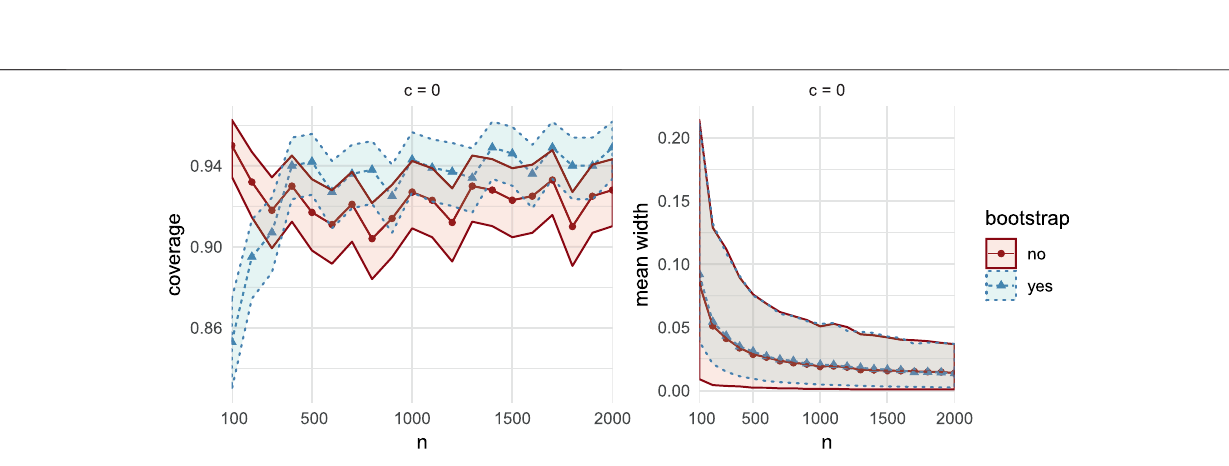
FIGURE 5 | Comparisons of coverage (left column) and mean width (right column) between bootstrap CIs (dashed lines with triangular markers) and the asymptotic CIs (solid lines with circular markers) in MC Study C, for correlation c (cid:2) 0. The horizontal axes display the sample sizes n (cid:2) 100 , 200 , ... , 2000.